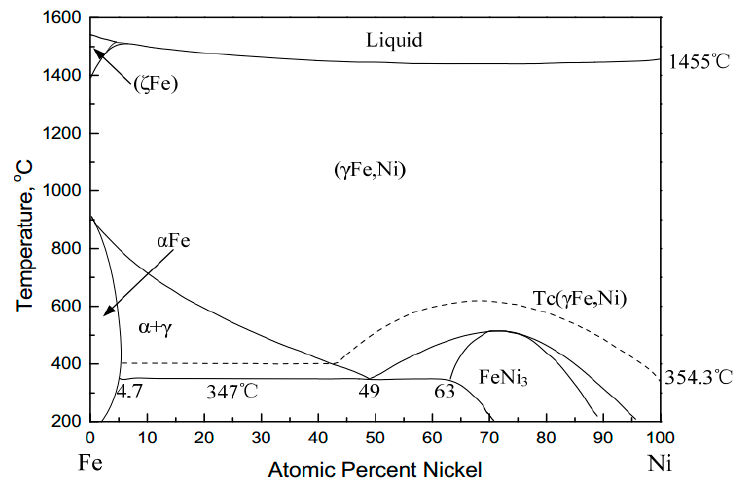
Figure 11. Phase diagram of Fe-Ni.